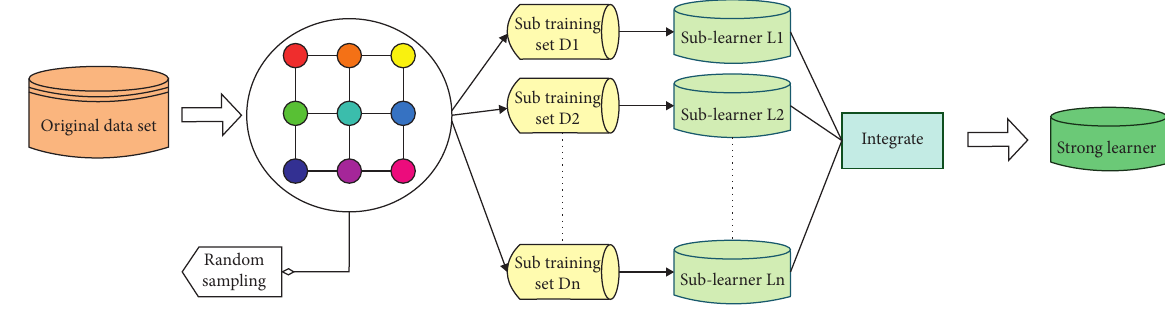
Figure 1: Bagging